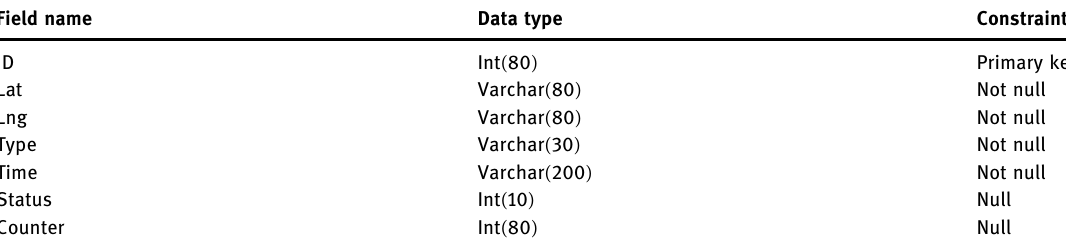
Table 1: Database